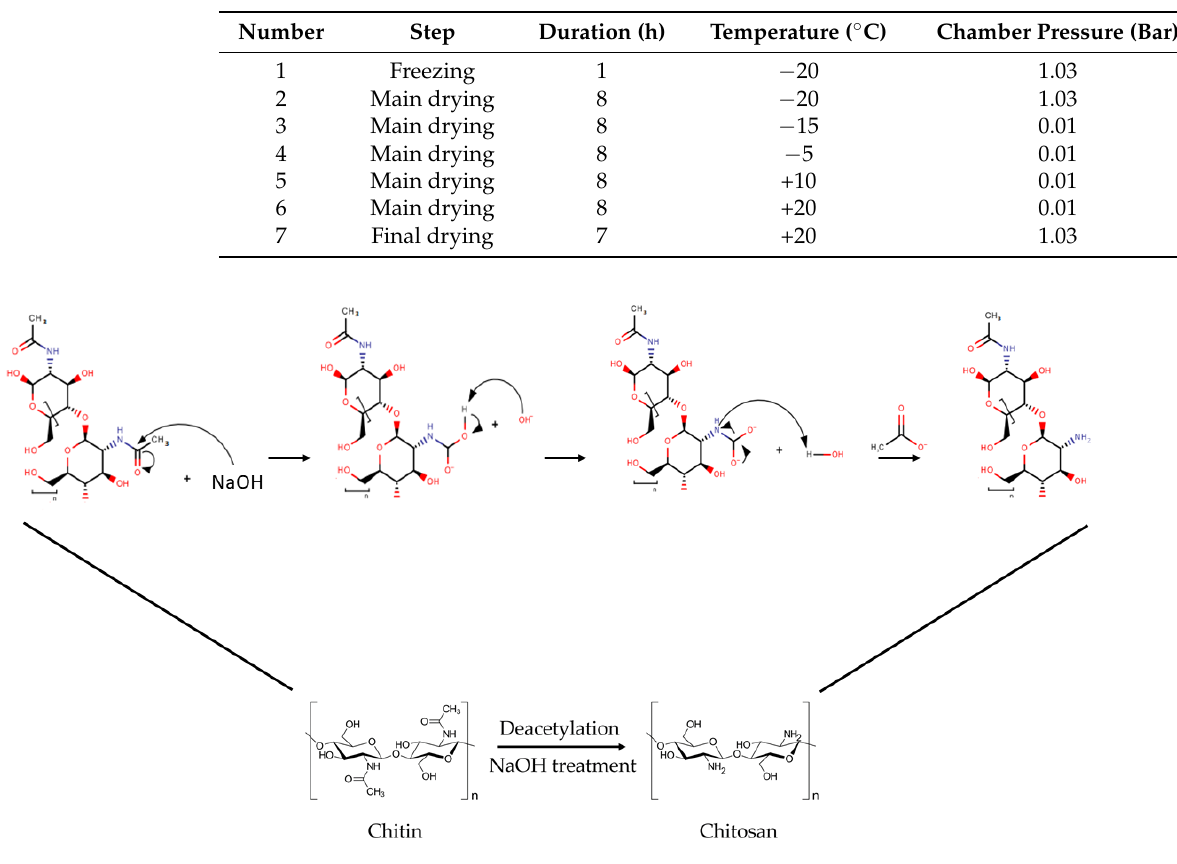
Figure A1. Chemical reaction for chitin deacetylation.